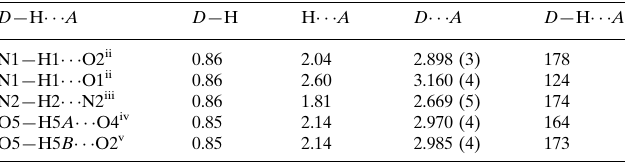
Hydrogen-bond geometry (A˚ , (cid:2)